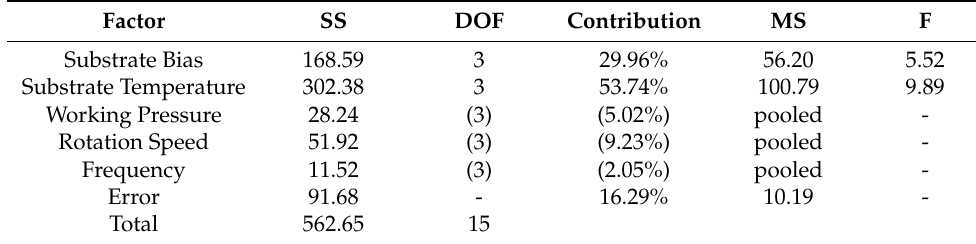
Figure 10. Taguchi analysis plot for film roughness, where the experimental factors (A, B, C, D and E) and levels (1, 2, 3 and 4) can be found in Table 1. The horizontal line across the figure represents the mean S/N ratio of the 16 trials. Table 5. ANOVA analysis results for film roughness. () indicates non-dominant